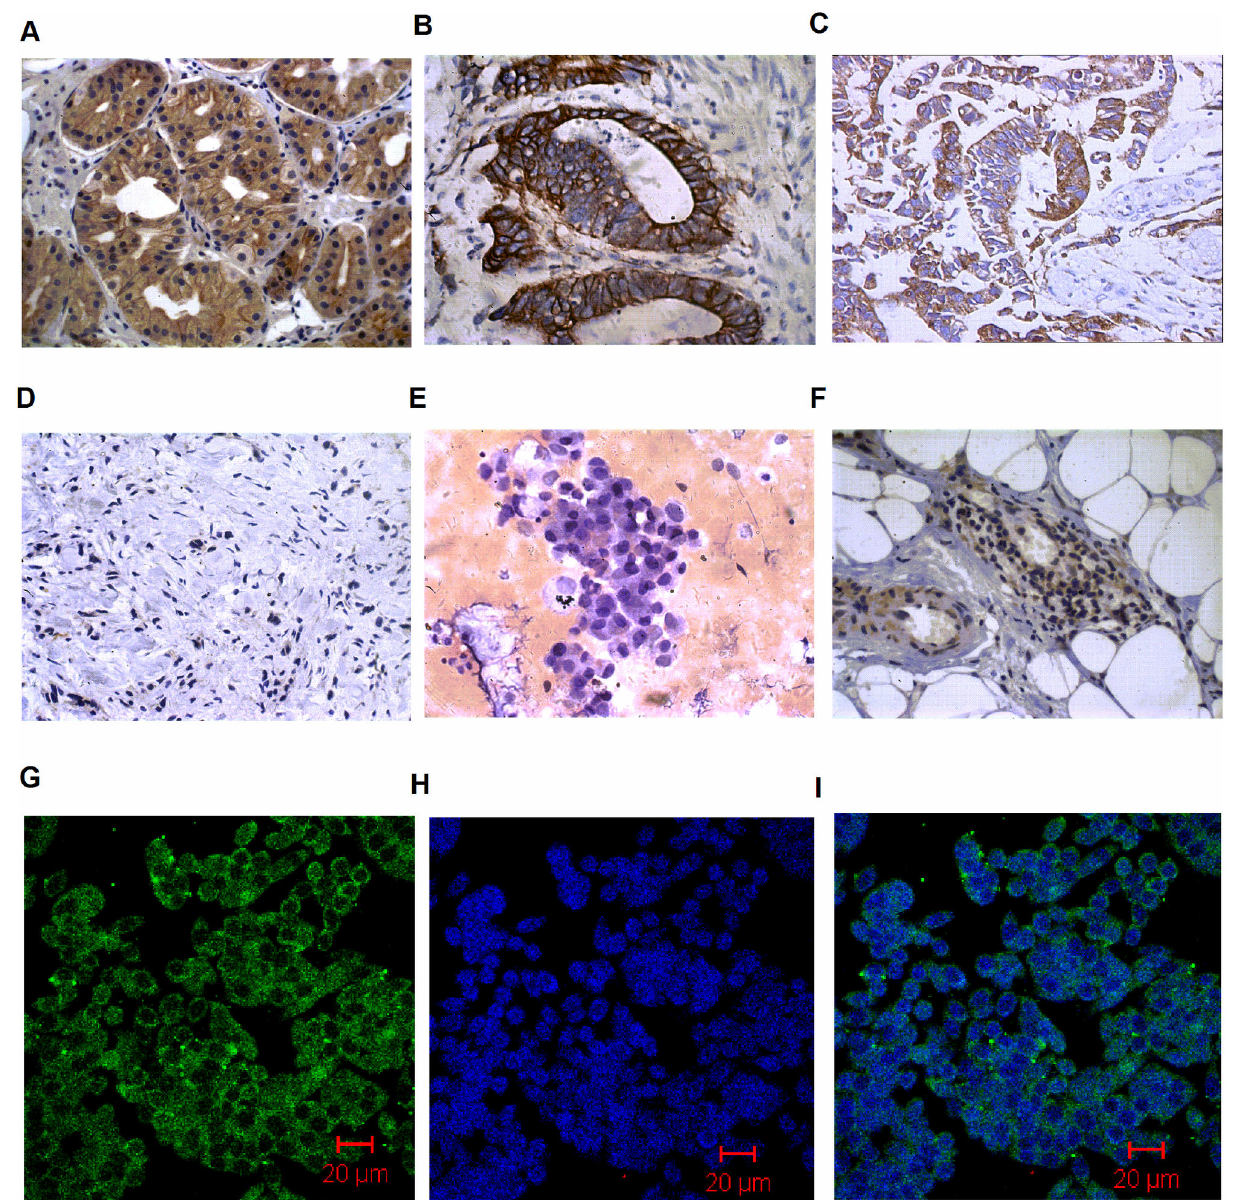
Figure 1. Cx43 expression in normal gastric tissue specimens, primary gastric carcinoma tissues, matched metastatic peritoneal tissues and intra-abdominal exfoliated gastric cancer cells. (A) Cx43 was expressed in normal epithelia with typical membranous and cytoplasmic staining. (B) Cx43 expression in well-differentiated gastric cancer tissues, cancer cells showed a positive membrane and cytoplasmic staining pattern. (C) Cx43 showed a major positive staining in cytoplasm in moderately differentiated gastric cancer tissues (D) Cx43 expression in poorly differentiated gastric cancer tissues, tumour cells show a negative staining pattern. (E) Cx43 expression in metastatic peritoneal tissues showed a positive staining pattern. (F) Intra- abdominal exfoliated gastric cancer cells were determined by Hematoxylin and eosin (H and E) staining. (G, H, I) The expression of Cx43 in intra-abdominal exfoliated gastric cancer cells was accessed by immunofluorescence. Original magnification: (A-F, ×400). doi: 10.1371/journal.pone.0074527.g001 GJIC with peritoneal mesothelial cells successfully. The min or 4 min after bleaching. The results show that, in Cx43- intracellular fluorescence intensity was detected before expressing group, the intracellular fluorescence intensity of bleaching, at the instant of bleaching, and either 1 min, 2 min, 3 bleached mesothelial cell decreased rapidly after bleaching.